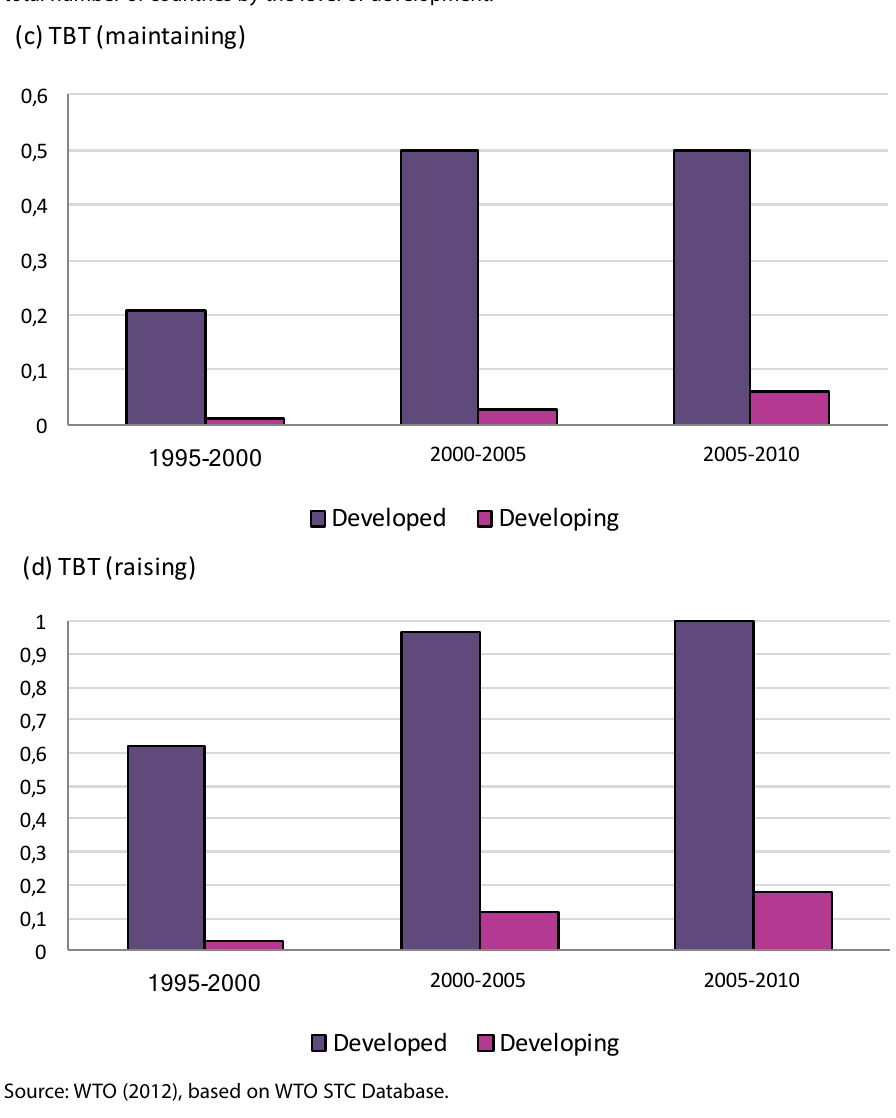
Figure 3. # TBT Specific Trade Concerns (STC) “Maintaining” and “Raising” countries as a share of the total number of countries by the level of